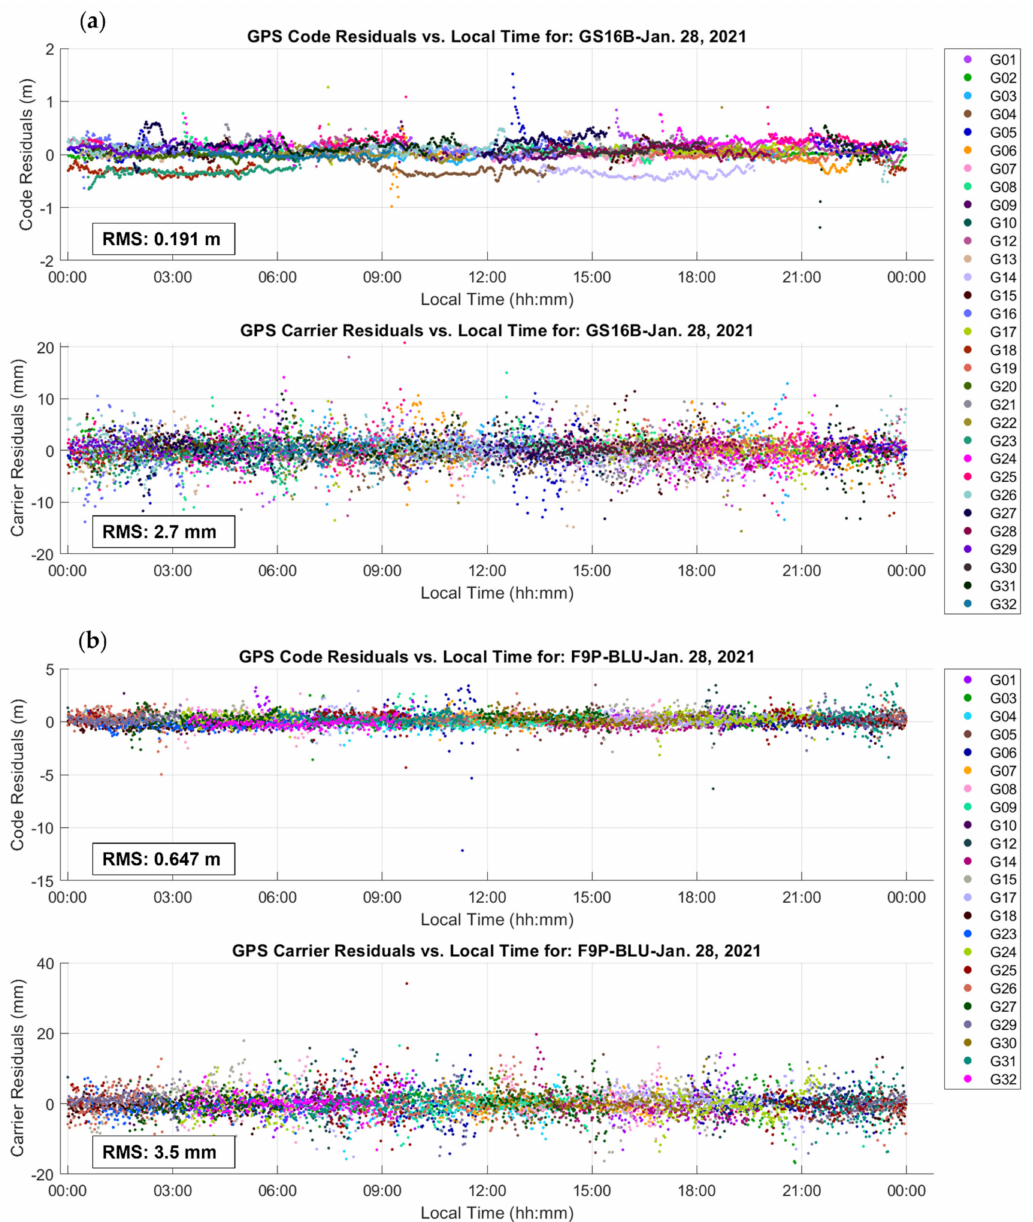
Figure 6. GPS L1 C/A code and carrier residuals of static PPP solution for 24 h of dataset A for: ( a ) GS16B receiver; ( b ) F9PBLU receiver using a NovAtel antenna. Vertical scales are different for each receiver. The F9P receiver shows fewer satellites as L2C is the only signal tracked in the GPS L2 frequency band; therefore, block IIR satellites (which do not broadcast the newer L2C signal) are not included in the dual-frequency PPP solution for this purpose. Local time is UTC −